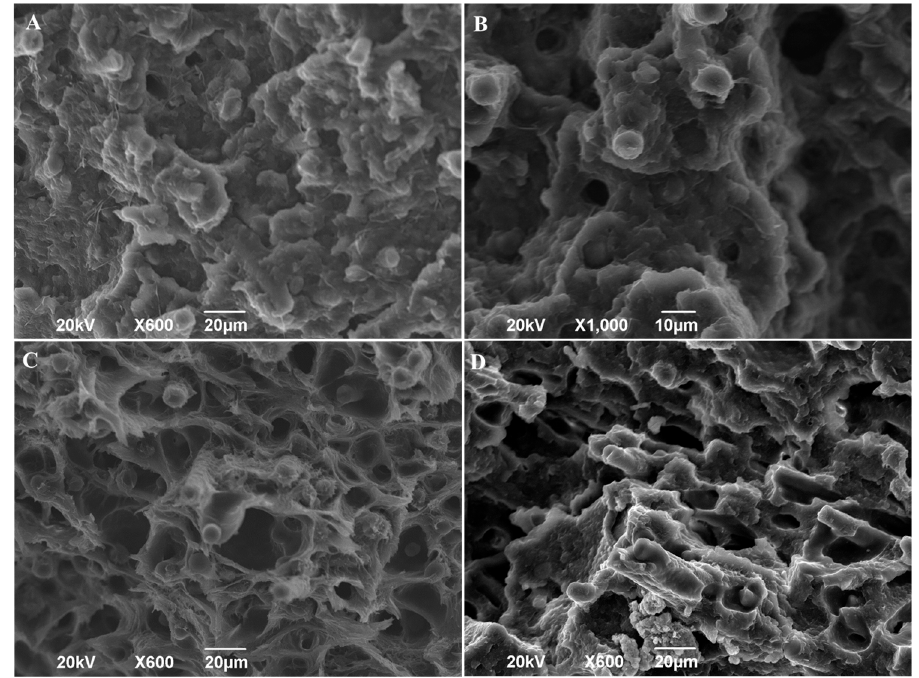
Figure 8. Fractographies of tested tensile samples: ( A ) Injection moulding 600×; ( B ) injection moulding 1000×; ( C ) 3D printed unidirectional 0° 600×; ( D ) 3D printed ±45° 600×.